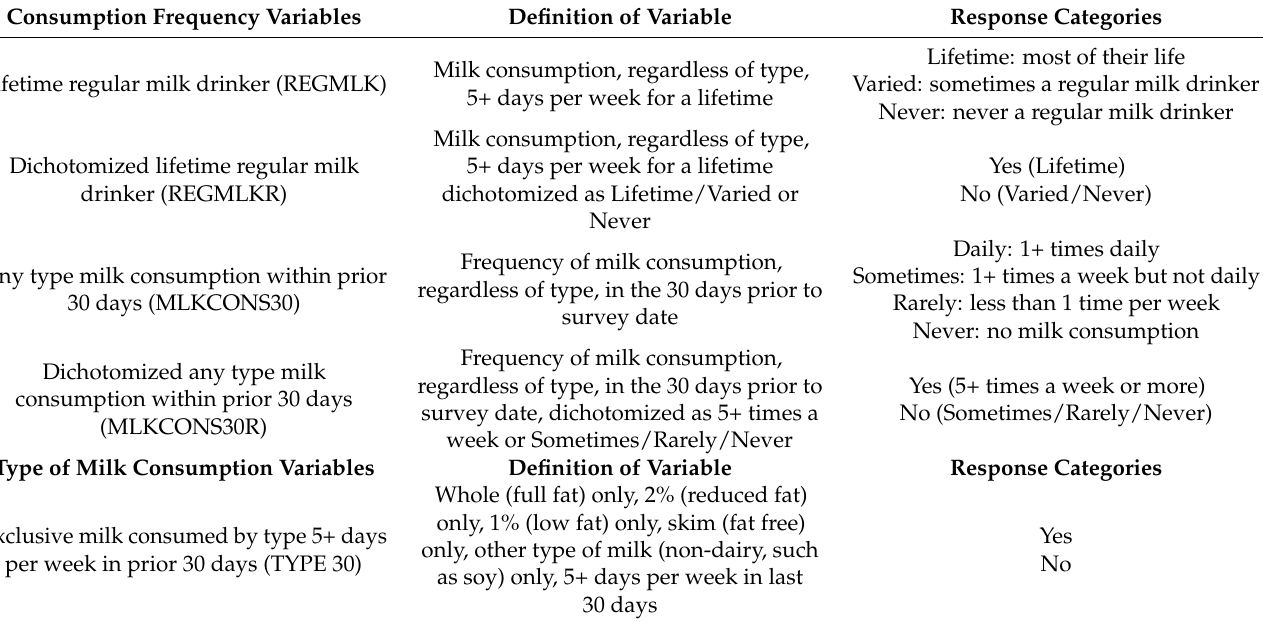
Table 1. Definition of terms used in